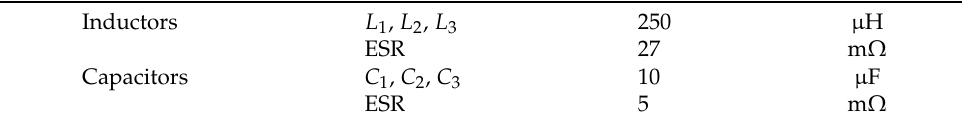
Table 4. DDSB converter design.